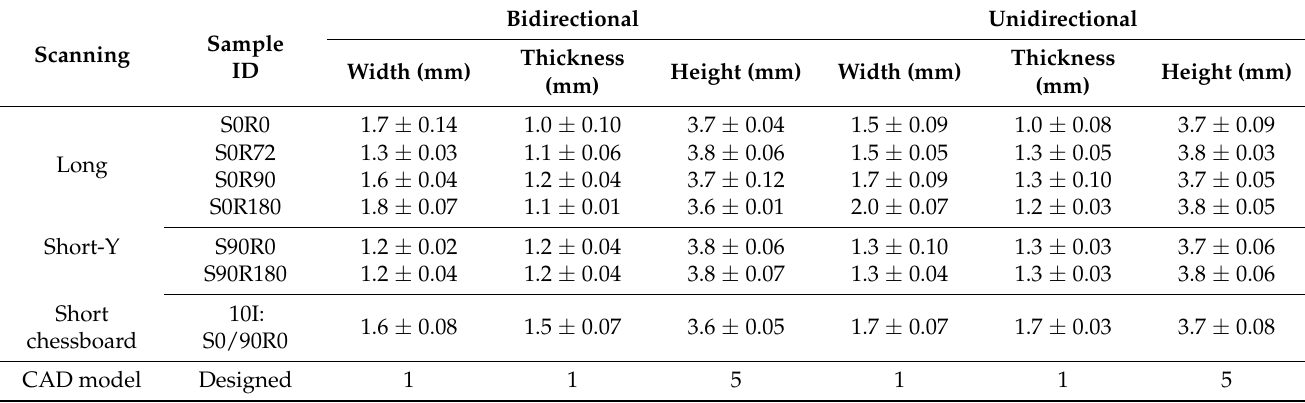
Table 4. The summary of the manufactured size of the supporting